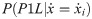
Conditional probabilities of each attractor in the Duffing oscillator for different resolution grids.Panels (a), (d) and (g) are the basins of attraction of the Duffing oscillator for grids of 50 × 50, 300 × 300 and 1000 × 1000 correspondingly. The points are colored according to which attractor an initial condition goes to. In panels (b), (e) and (h) we have plotted the conditional probabilities associated with each vertical line of the phase space, P(P1L|x˙=x˙i) (red), P(P1R|x˙=x˙i) (green) and P(P3|x˙=x˙i) (blue). In panels (c), (f) and (i) we have plotted the conditional probabilities associated with each horizontal line of the phase space, P(P1L|x = xi) (red), P(P1R|x = xi) (green) and P(P3|x = xi) (blue).